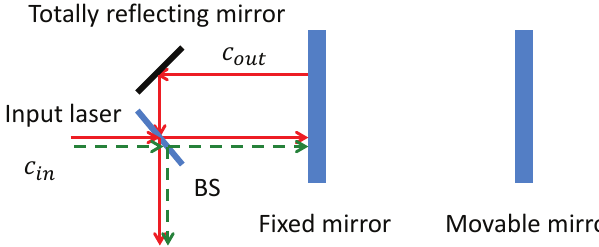
Figure 1. A schematic diagram of the optomechanical system with a coherent feedback. An input laser is sent into the cavity through an asymmetric beam splitter (BS). A portion of the output field is fed back into the cavity via a completely reflecting mirror and the BS. The c in is the optical vacuum noise that is incident on the